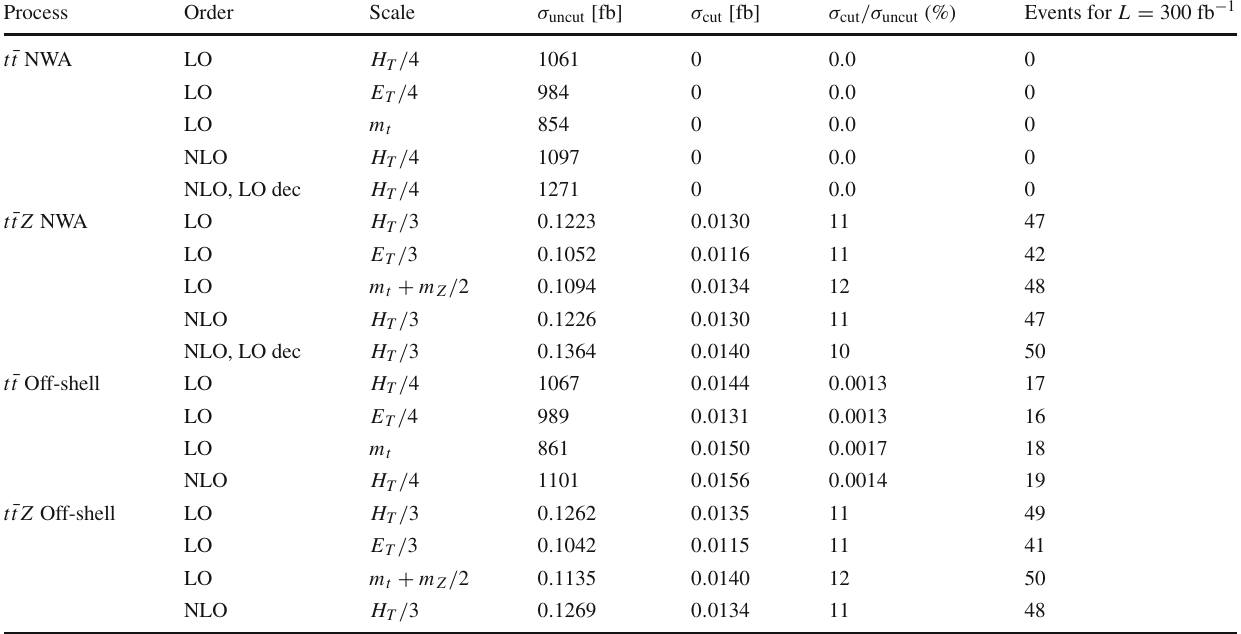
Table 3 Comparison of LO and NLO integrated cross sections for the employ the (N)LO CT14 PDF set as our default PDF set. The numbers two background processes in the NWA (top) and including full off-shell of events are given for an integrated luminosity of L = 300 fb − 1 and effects(bottom)before andafterapplyingtheadditionalcuts.Allvalues include the lepton flavour factors (4 for the DM signal and t ¯ t , and √ s = 13TeV.We aregivenfortheLHCwithacenterofmassenergyof